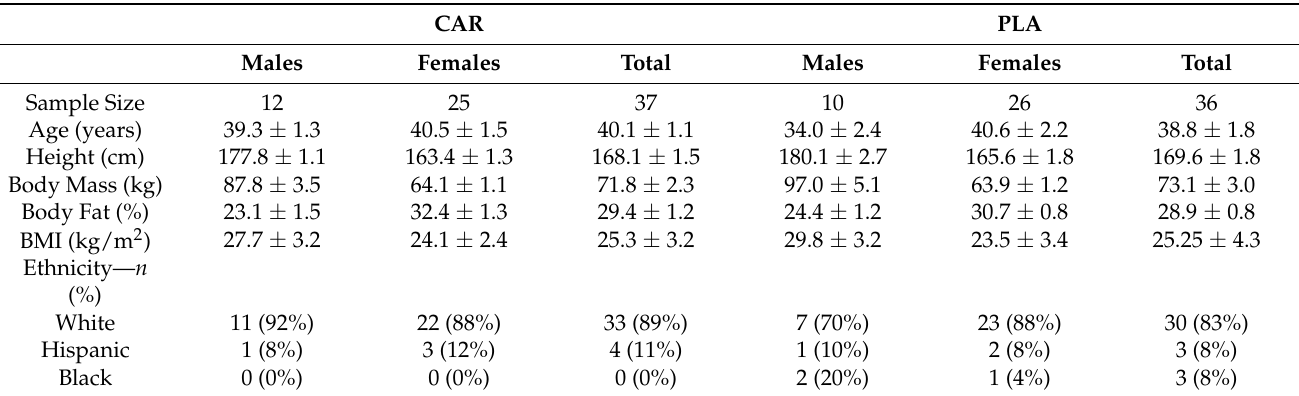
Figure 1. CONSORT flow diagram. CAR: L-carnitine group; PLA: placebo. Table 1. Baseline Subject